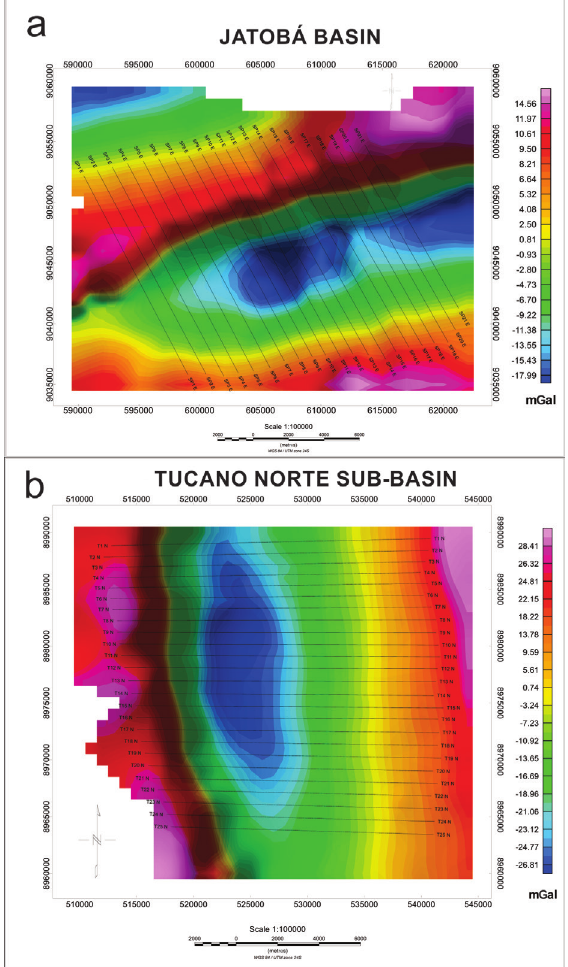
Figure 2. Trend surface maps of the Bouguer anomaly in the study region in the Jatobá Basin (a) and Tucano Norte Sub-basin (b), with the locations of the profiles selected for 2.5D